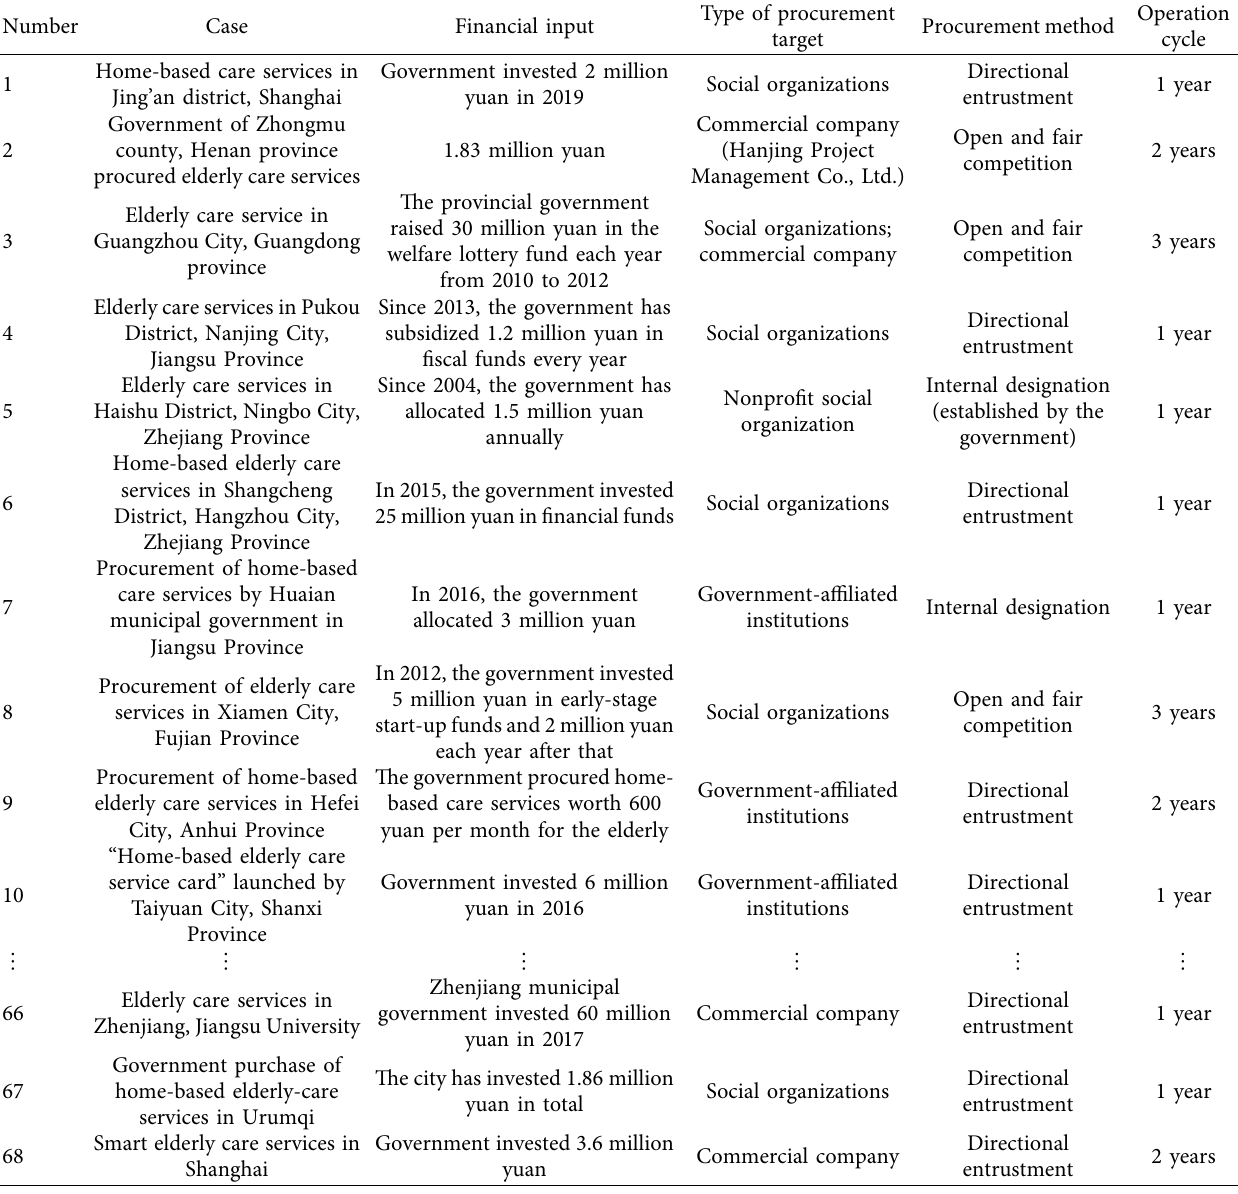
Table 1: Case summary of government procurement of elderly care